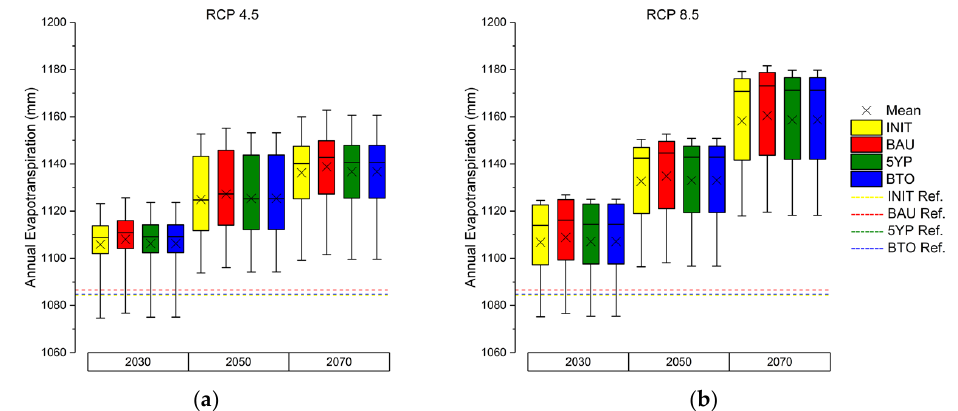
Figure 3. Annual average evapotranspiration in Nabanhe Reserve calculated with InVEST and ensemble data (9 GCMs) of two Relative Concentration Pathways (RCP 4.5 ( a ) and RCP 8.5 ( b ) of the Fifth Assessment Report of the IPCC) for the time slices of 2030 (20-year average from 2020–2040), 2050 (20-year average from 2040–2060) and 2070 (20-year average from 2060–2080). Boxes and whiskers show the 25/75 and 10/90 percentiles respectively. Lines in boxes show the ensemble median, whereas crosses show the ensemble mean. Colors represent land use conditions: Initial case of 2015 (INIT, yellow), Business-As-Usual scenario (BAU, red), 5-years-plan scenario (5YP, green), Balanced-Trade-Offs scenario (BTO, blue). The dotted lines show annual average evapotranspiration calculated with long-term annual average climate data as a baseline (WorldClim v1.4. [39,40]). Forests 2019 , 10 , x FOR PEER REVIEW Water yield results were averaged across all cells in the study area in Figure 4. The simulated water yield for the baseline climate data and the initial land use was about 375 mm in Nabanhe Reserve. Differences between the initial land use and both 5YP and BTO were only ±1% at watershed scale for each climate condition ( p < 0.5). On the other hand, the model results indicate a lower water yield ranging from −3.3% to −4.1% (depending on the climate condition) in BAU, when compared to the simulated water yield for the initial land use condition ( p < 0.5). Both the median and the mean ensemble results of water yield for time slice 2030 in RCP 4.5 were lower in comparison to the baseline climate. This was due to increasing temperatures, which lead to higher potential evapotranspiration (Figure 3). As the mean and median precipitation values in the ensemble input data remained at the same level as the baseline climate data (Figure 1), the higher evapotranspiration leads to a reduction in simulated water yield in 2030 for both RCP 4.5 and RCP 8.5. An increasing trend for precipitation in 2050 and 2070 increased projected water yield also in RCP 4.5. Baseline evapotranspiration values